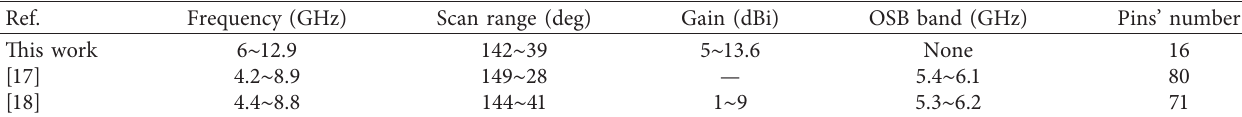
Table 2: Comparison of the proposed antenna with previous antenna design.